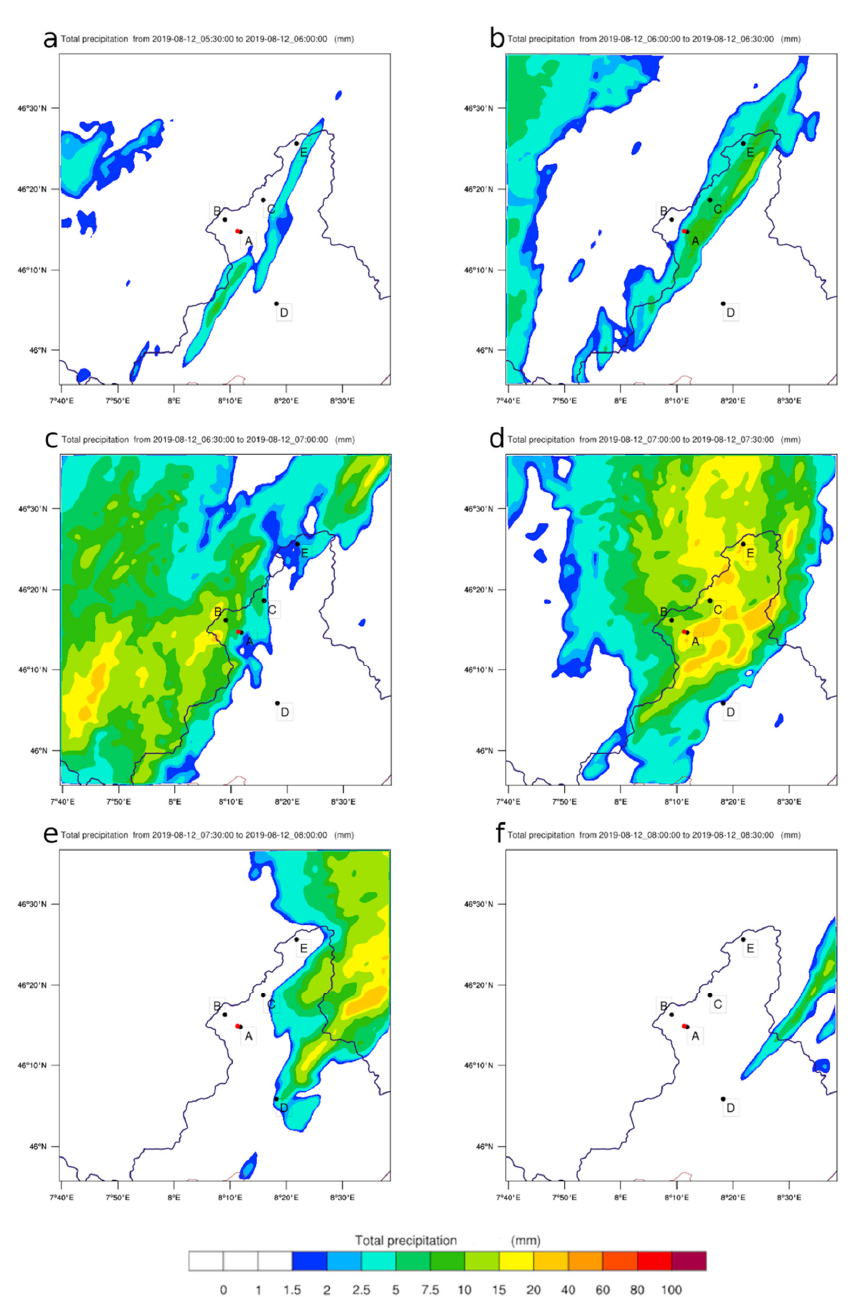
Figure 8. The 12 August 2019 precipitation event simulated with WRF, precipitation totals in 30 min from ( a ) 0530 UTC to ( f ) 0800 UTC at 30 min step. Black dots with letters are the locations of weather stations (see Table 1), while the red dot indicates the position of the bridge on the Croso stream.